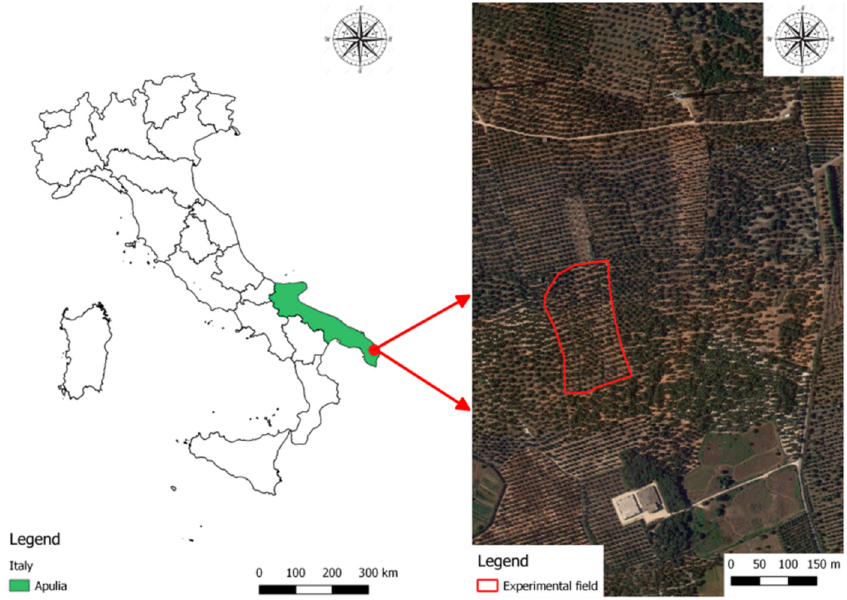
Figure 1. Area and experimental fields location. EPSG: 32633; CRS: WGS84-UTM33T.